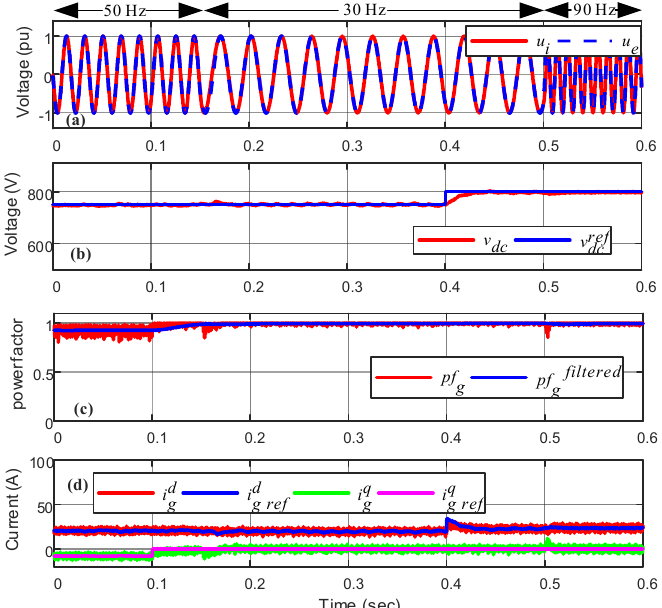
Figure 8. Nonlinear control response; ( a ) synchronization; ( b ) dc voltage; ( c ) power factor; ( d ) input rectifier currents.